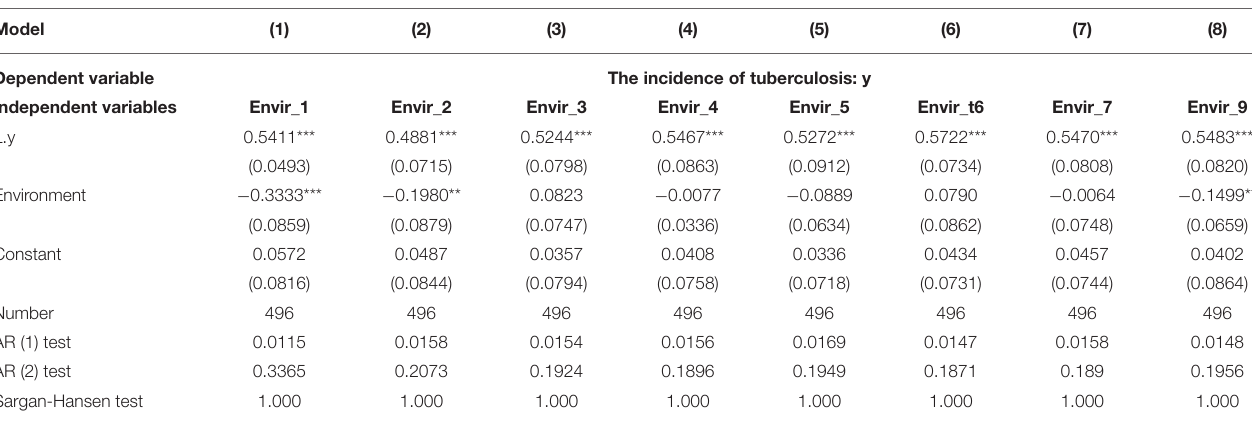
TABLE 4 | Estimation results of the impact of living environment variables on the incidence of tuberculosis.